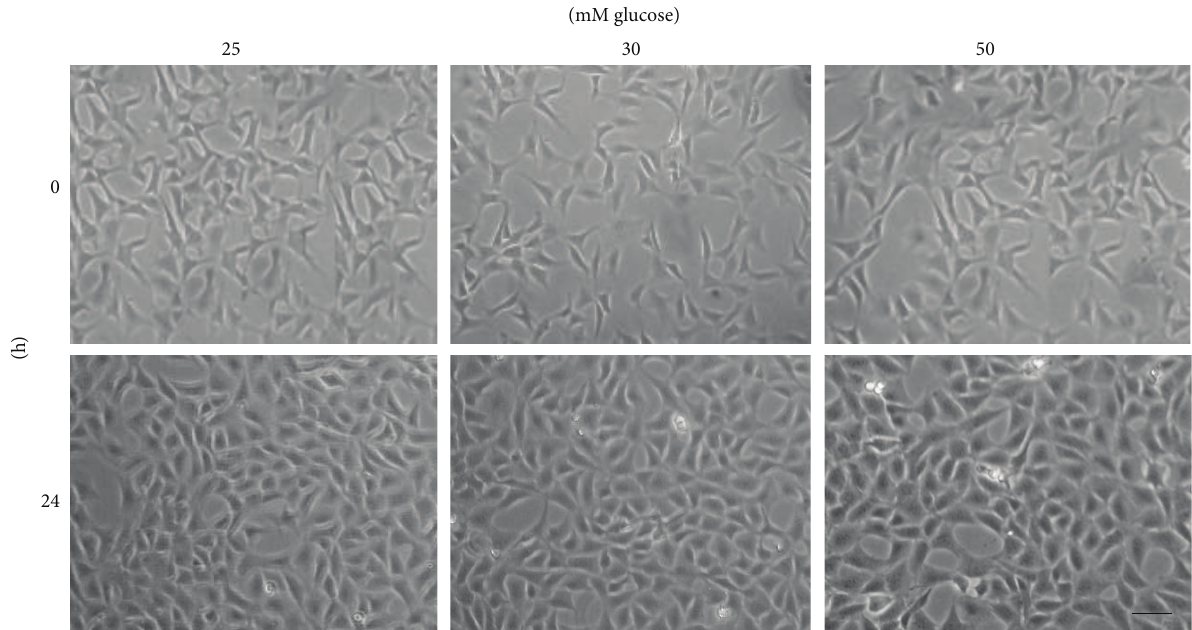
Figure 1: Influence of high glucose on the morphology of HT22 cells as observed after 24 hours of culture: under inverted microscope the 25 mM glucose (control) group and 30 mM glucose stimulation group displayed spindle or multipolar shaped cells with full and transparent cell body with excellent growth, whereas the 50 mM glucose stimulation group showed a reduction in cell attachment and numbers with a significant decrease in light refraction (scale bar 10 𝜇